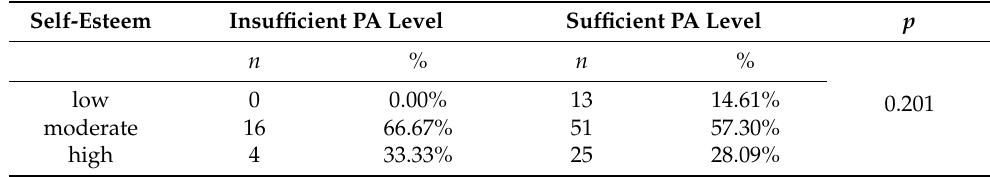
Table 5. Self-esteem level according to PA levels.